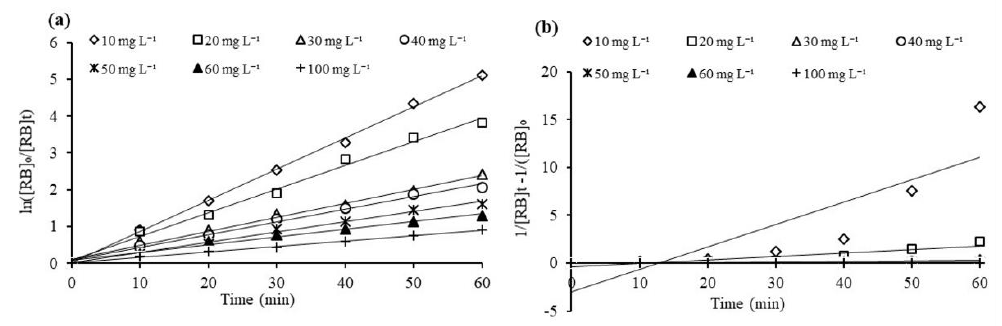
Figure 11. ( a ) PFO; ( b ) PSO kinetics of RB5 azo dye photodecolorization using 0.1Fe-TiO 2 -300.